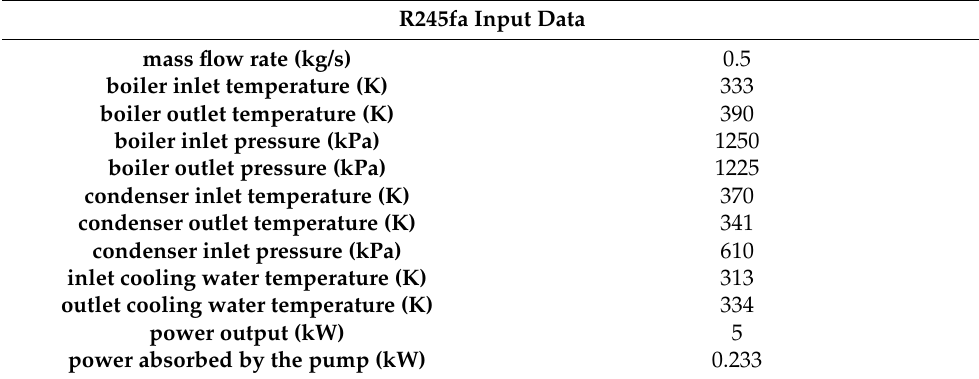
Table 1. ORC plant simulation